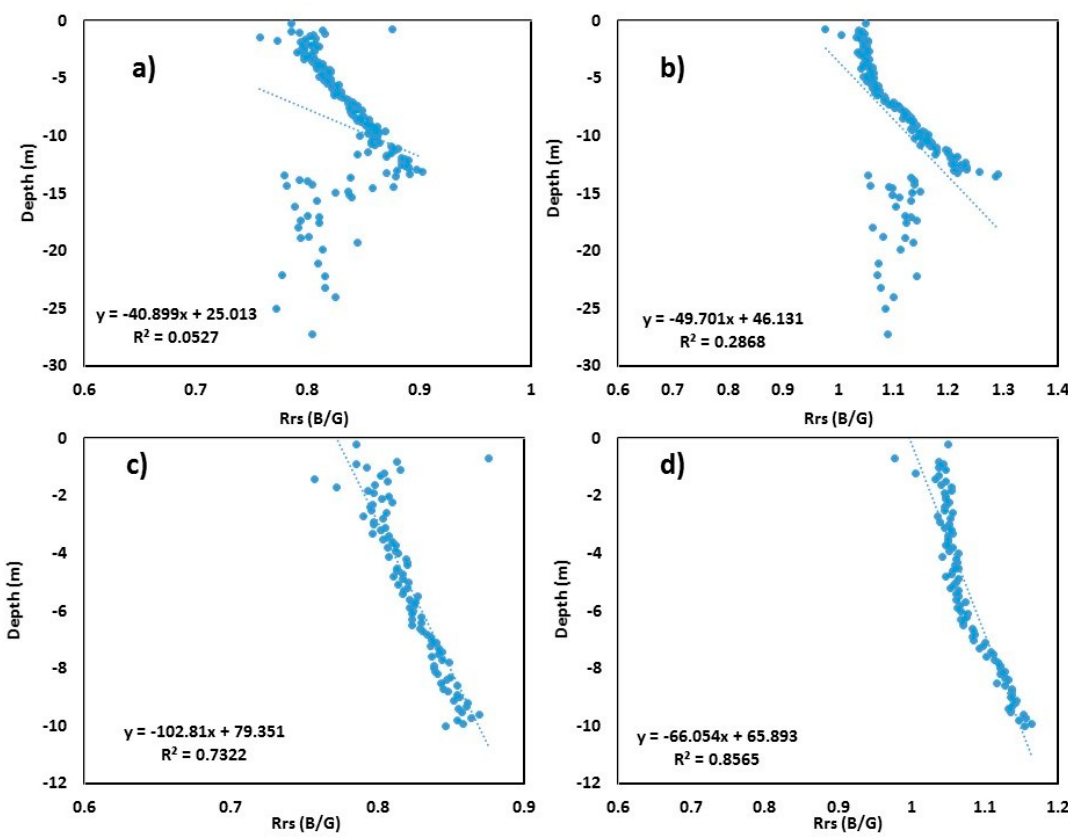
Figure 4. Scatter plots of blue / green (B / G) band versus surveyed depth for Tampa Bay: ( a ) Sentinel-2 B / G vs. surveyed bathymetry up to 30 m depth; ( b ) Landsat-8 B / G vs. surveyed bathymetry up to 30 m depth; ( c ) Sentinel-2 B / G vs. surveyed bathymetry up to 10 m depth; ( d ) Landsat-8 B / G vs. surveyed bathymetry up to 10 m depth.